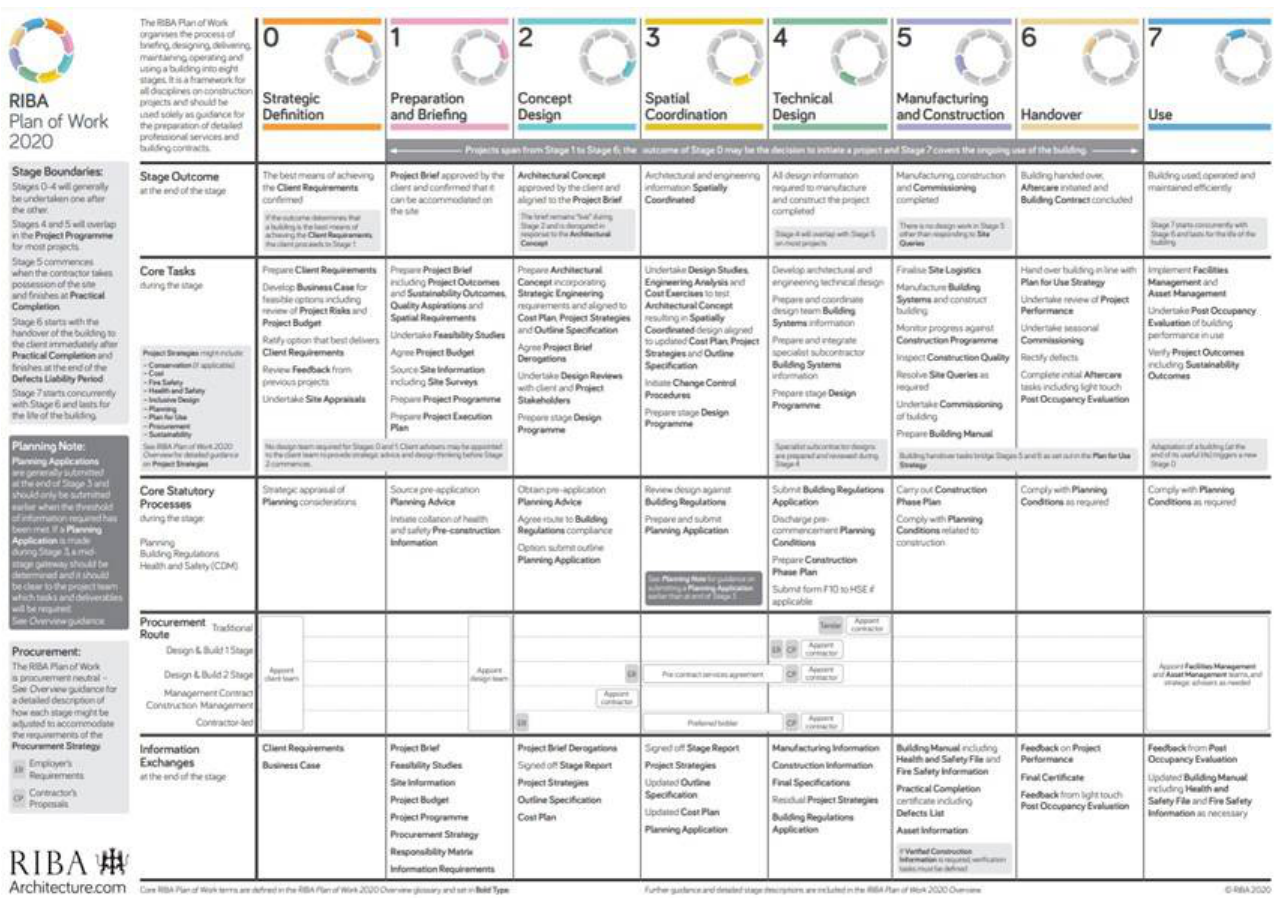
Figure 8. RIBA Plan of Work 2020.